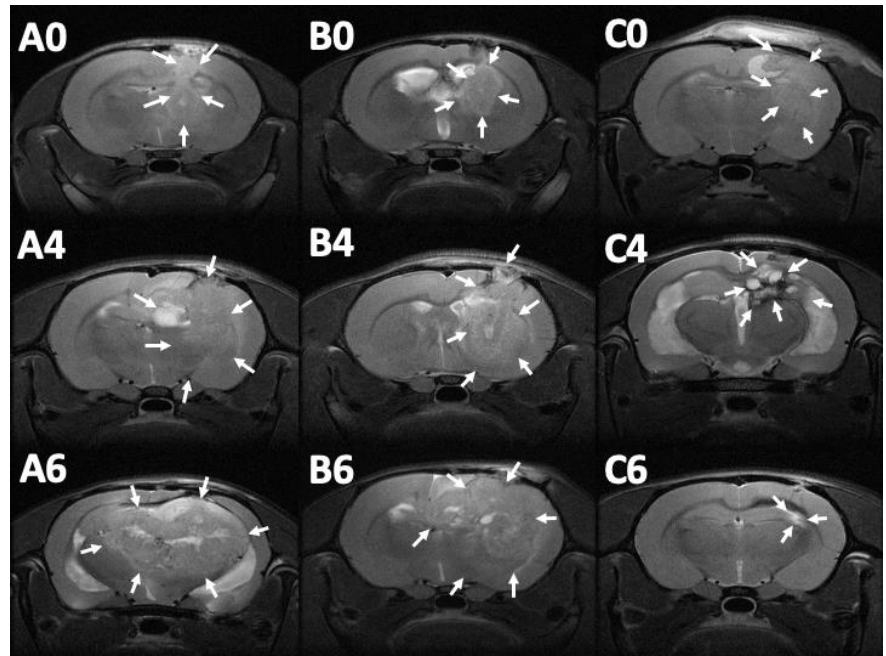
Figure 8. Serial magnetic resonance imaging . The label in the upper-left corner of each image denotes the number of posttreatment weeks. No significant primary discrepancy was noted among the brain tumors in groups A (A0), B (B0), and C (C0). The tumor in groups A and B increased promptly with an obvious mass effect. A rigorous midline shift with bilateral ventricle affection was found in group A (A4 and A6). The tumor expanded inwardly (B4) then traversed the midline (B6). The tumor size reduced gradually in group C, after injection of SMPs (C4 and C6), while no perifocal edema was noticed (the tumor areas are indicated by white arrows).